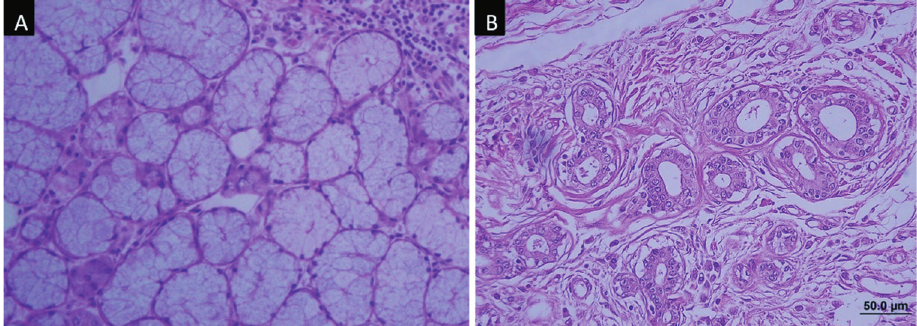
Figure 1- A: Normal gland – 26 years old (Group I). Preserved acini and absence of duct-like structures (DLS) are observed; B: Altered gland – Presence of DLS, absence of acini and substitution of the glandular parenchyma by connective tissue – 68 years old (Group II) (hematoxylin and eosin 100X)